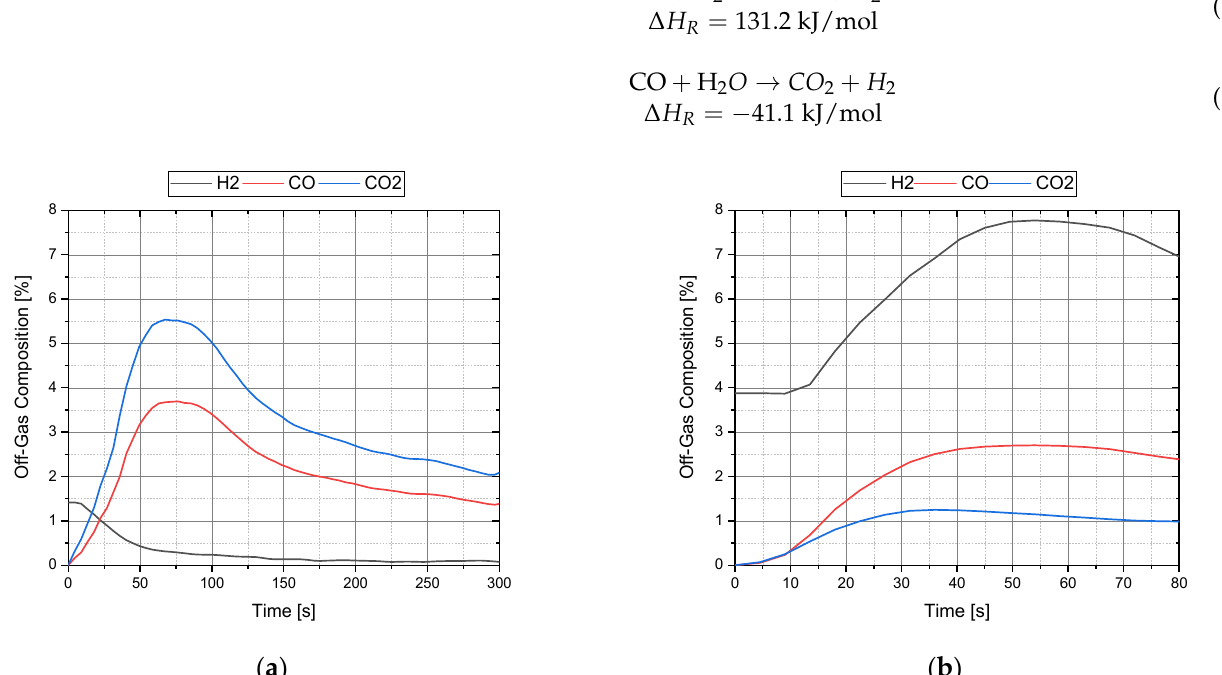
Figure 3. Off-gas composition at the pre-reduction phase for Ex. 1 ( a ) and Ex. 4 ( b ).